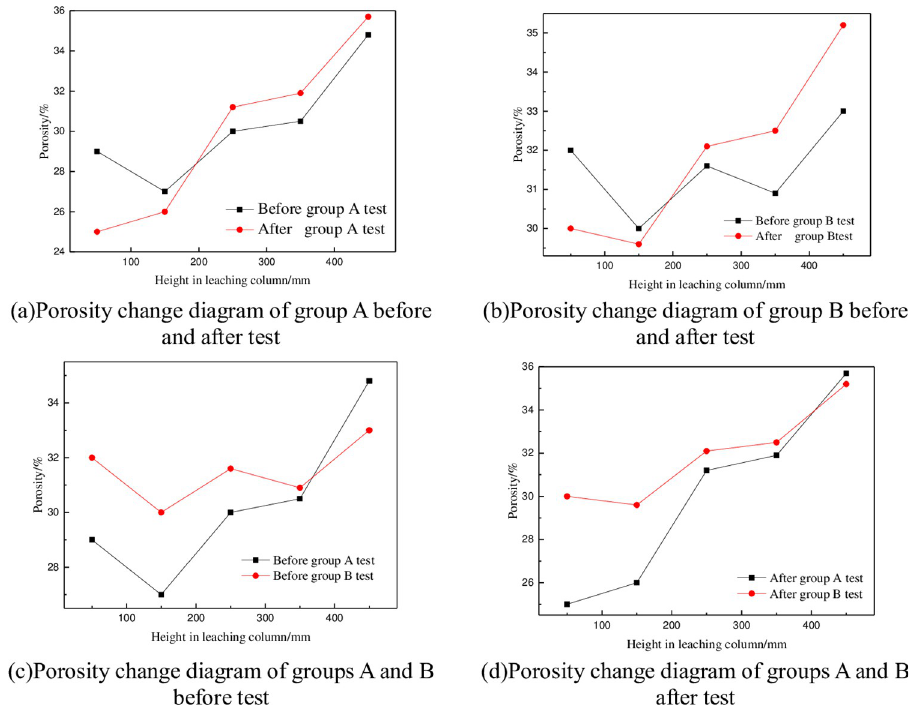
Fig 6. Changes in ore porosity before and after group A and B tests. (a)Porosity change diagram of group A before and after test. (b)Porosity change diagram of group B before and after test. (c)Porosity change diagram of groups A and B before test. (d)Porosity change diagram of groups A and B after